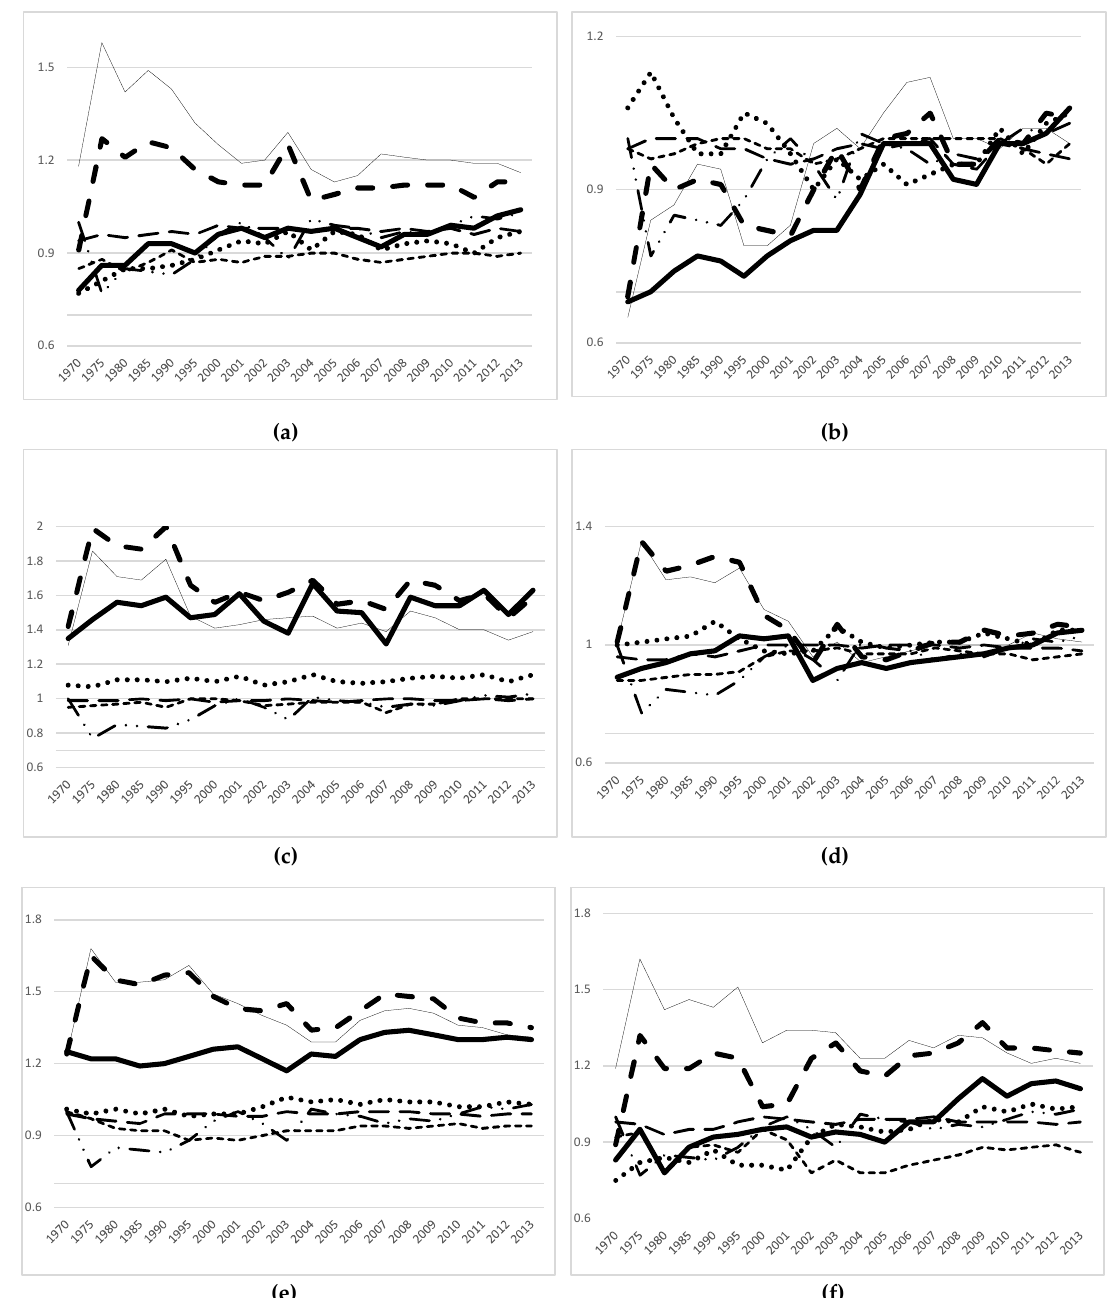
Figure 2. Global TFP change and its components during 1969–2013.